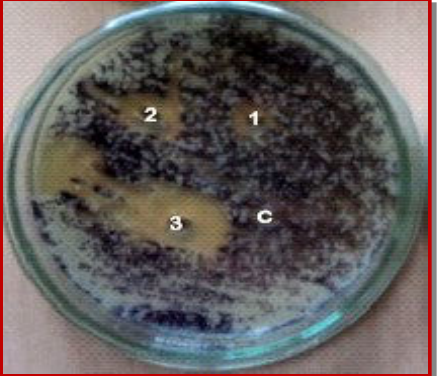
Figure 5: Bioassay for anti-quorum sensing activity of AgNPs